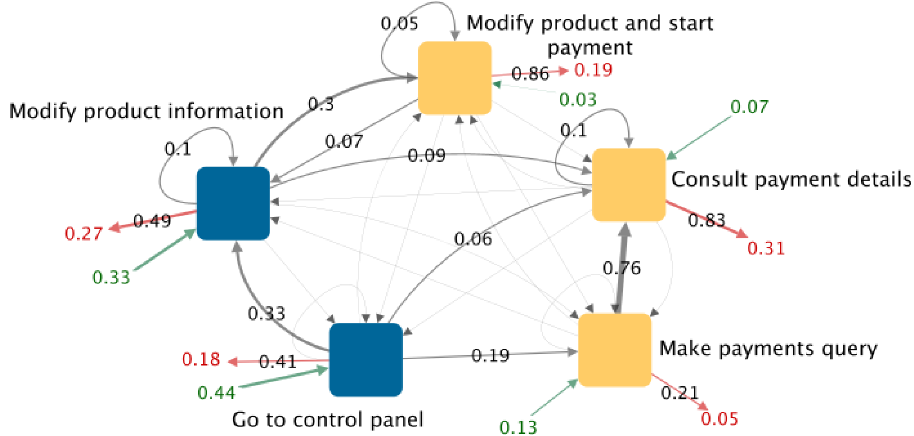
Figure 8. Graph of shrinked sessions for visitors from the class “Started payment”. Yellow nodes are the rules where the payment is